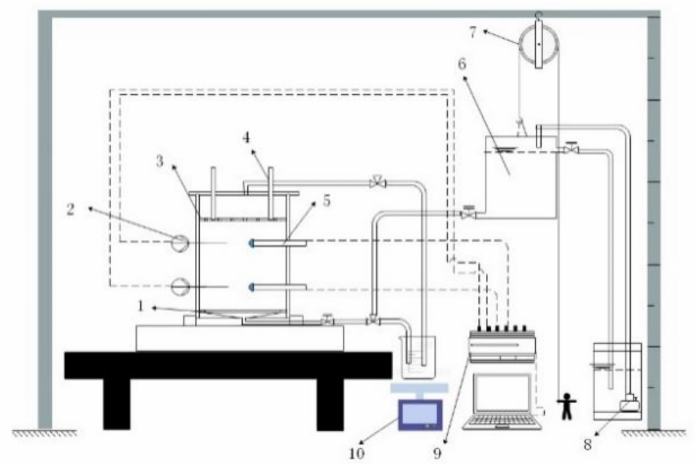
Figure 1. Diagram of combined testing system: 1—base, 2—moisture content sensor, 3—porous permeable board, 4—screw, 5—tensiometer, 6—scale bucket, 7—pulley, 8—pump, 9—data acquisition